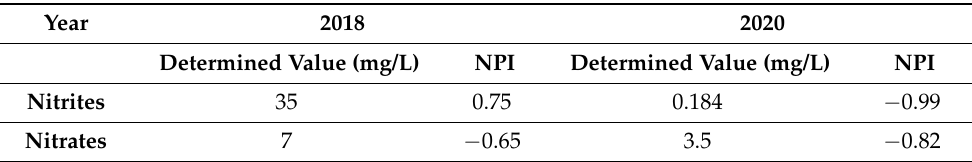
Table 2. Determinations of nitrites, nitrates, and NPI values for Lake